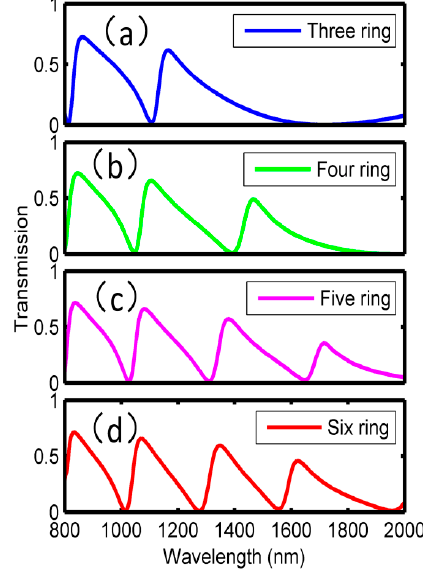
Figure 5. Multiring resonator transmission spectrum.